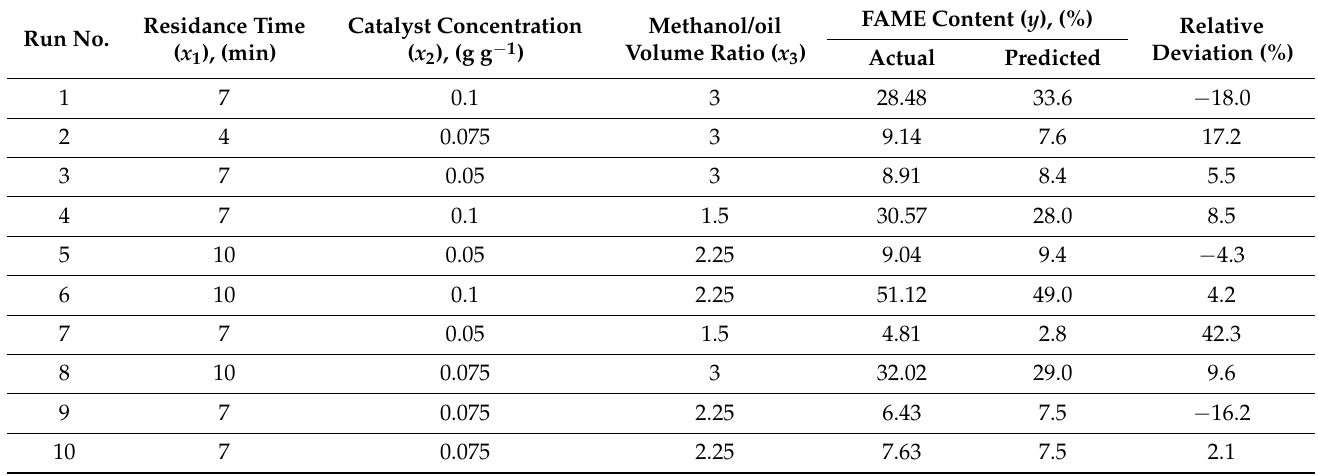
Table 2. The experimental matrix of the applied factorial design and the comparison of actual and predicted values of fatty acid methyl esters (FAME) content using the reduced quadratic model. Run